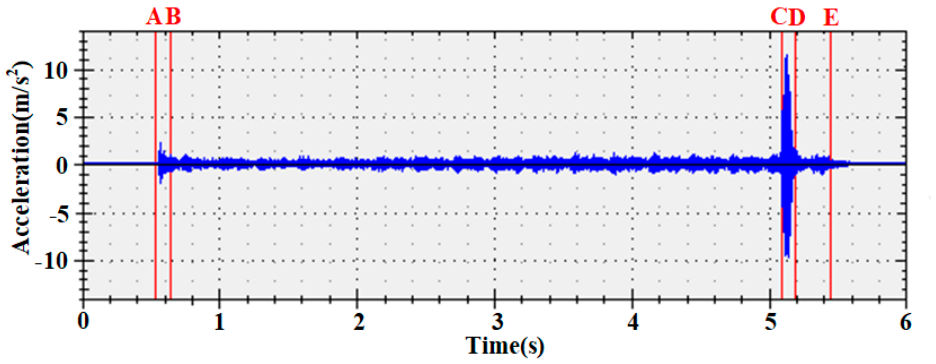
Figure 2. Measured waveform of the vibration signal during the normal action of the OLTC.